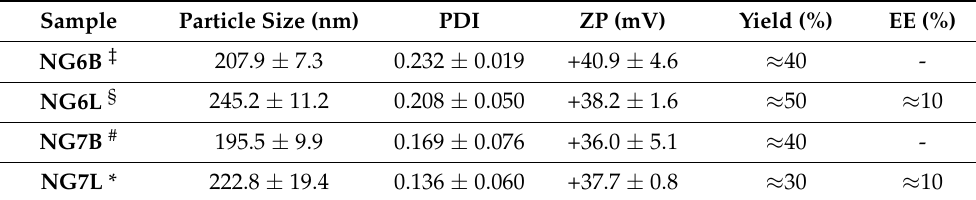
Table 2. Characteristics of blank and loaded nanogels (mean ± sd, analysis in triplicate on 2 *, 3 # , 4 § or 5 ‡ different